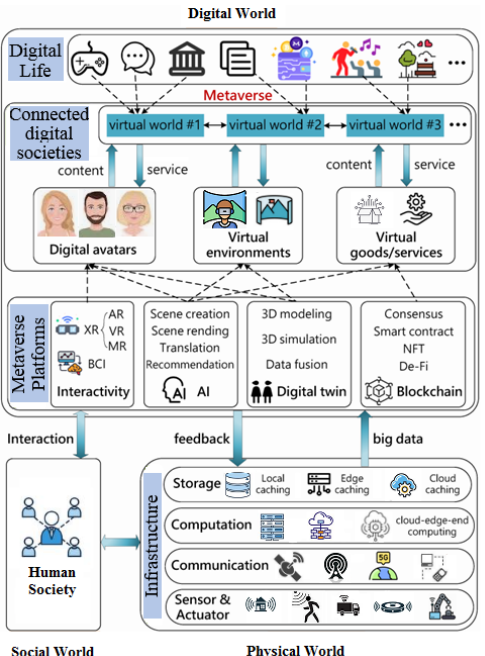
Figure 8. Metaverse architecture of integrated social, physical and digital worlds, modified based on [165]. The social world mainly consists of human communities.